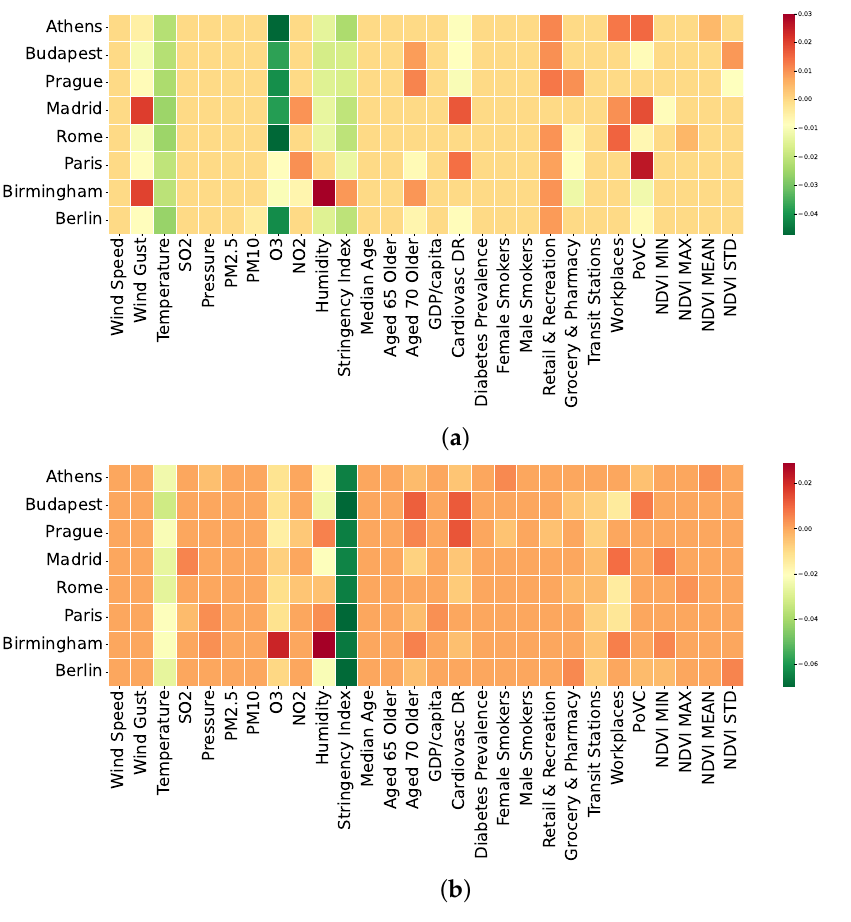
Figure 6. Local feature understanding using LIME framework. The contribution of each feature to each city is illustrated with heatmaps for 2020. Each row represents, for each city ( y -axis), the LIME- calculated weights for each indicator ( x -axis). Green color suggests negative influence to the model’s outcome, while a red one is positive. ( a ) Heatmap of LIME weights for cases model; ( b ) heatmap of LIME weights for deaths